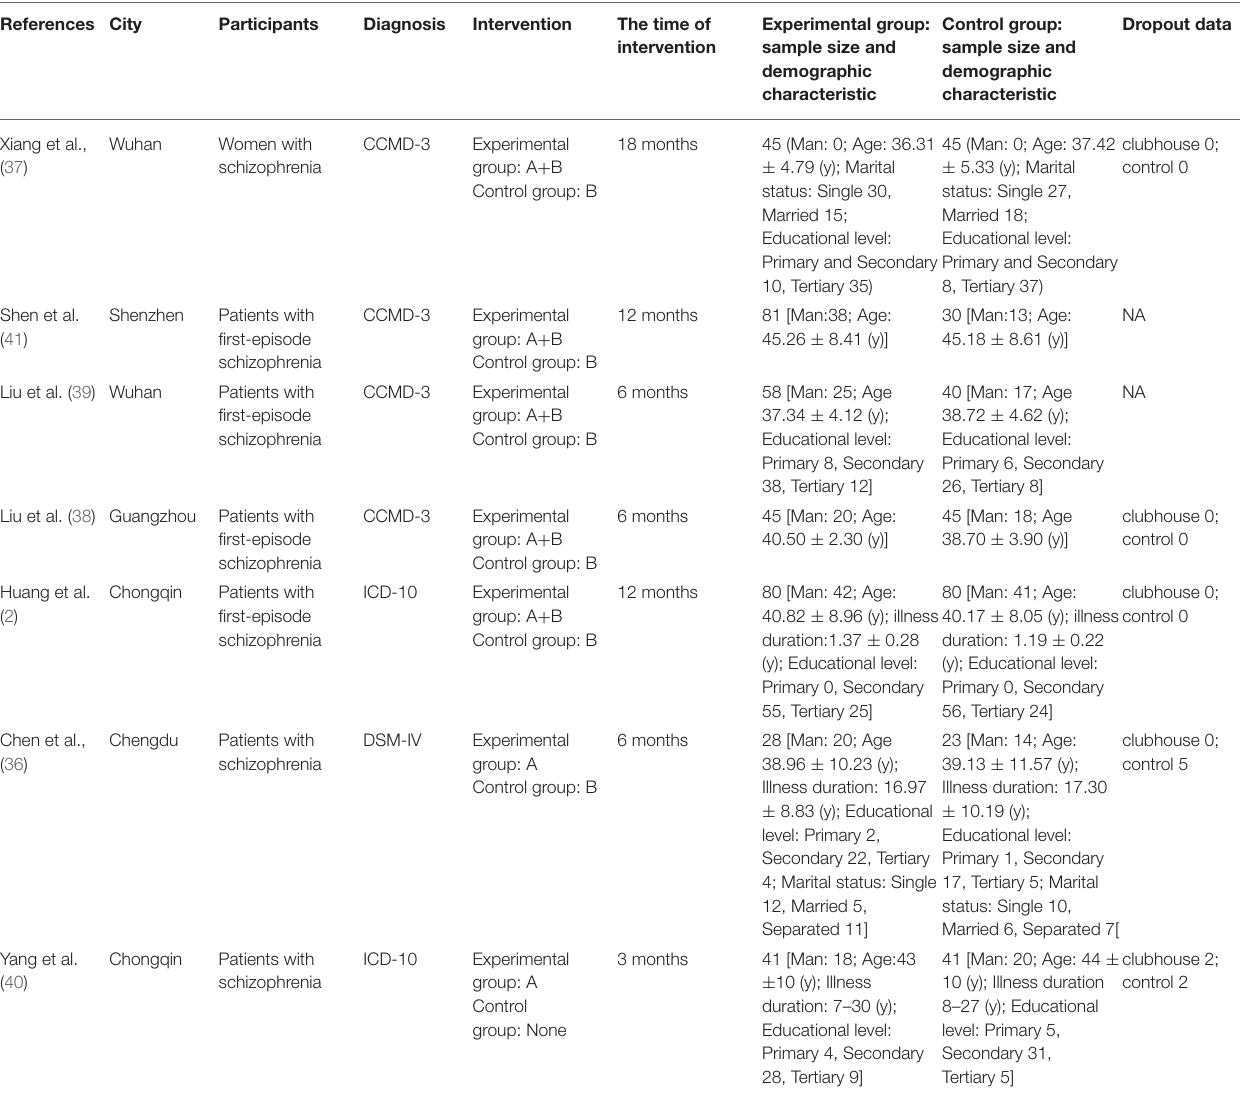
TABLE 1 | Characteristics of the included randomized controlled